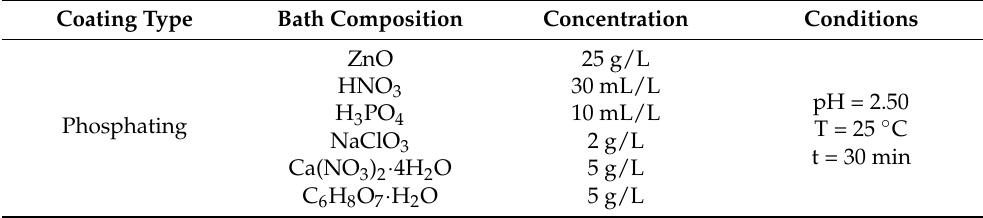
Table 1. Chemical compositions of the phosphating solution and treatment conditions. Coating Type Bath Composition Concentration Conditions